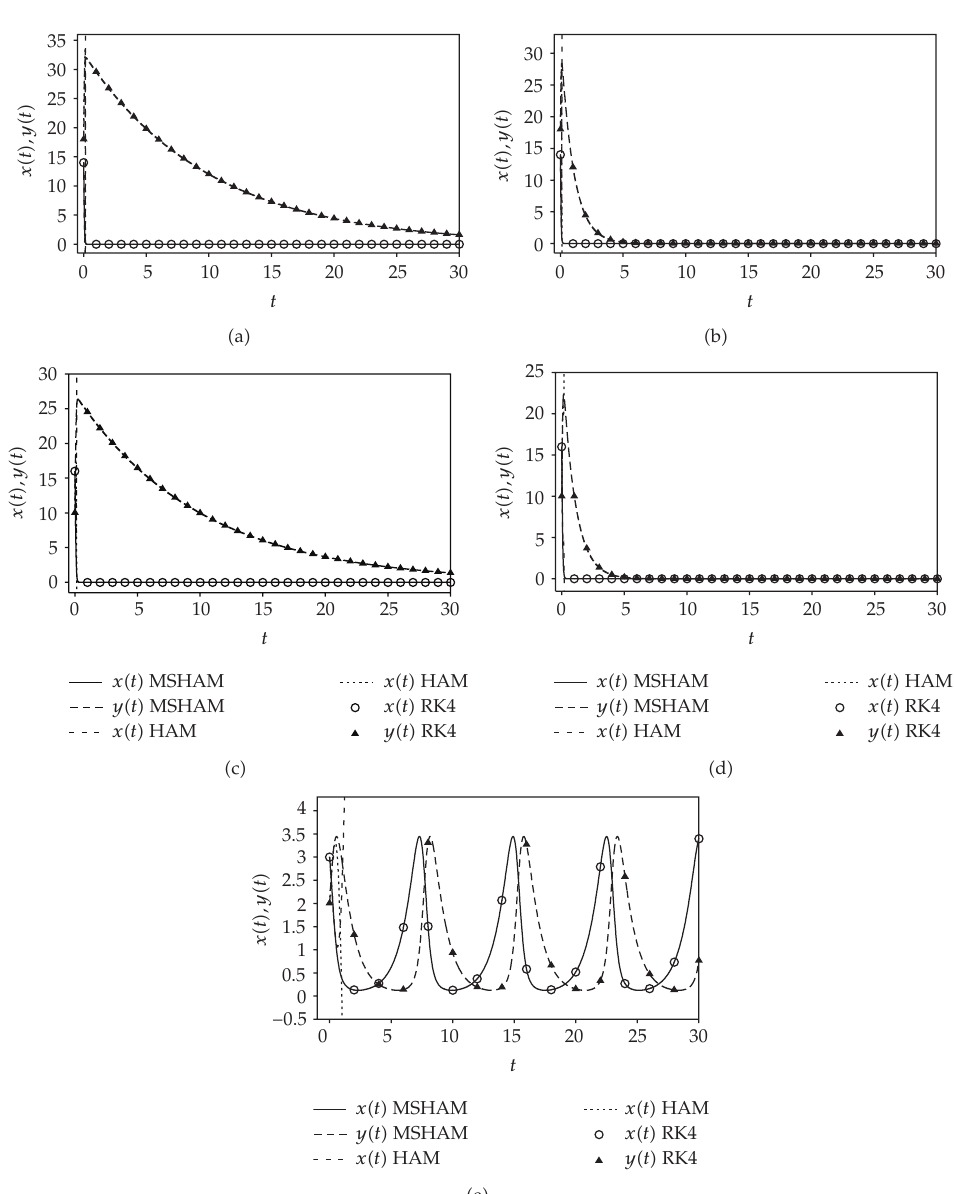
Figure 2: Comparisons between the populations of rabbits x and foxes y at time t for (cid:3) a (cid:4) Case 1, (cid:3) b (cid:4) Case 2, (cid:3) c (cid:4) Case 3, (cid:3) d (cid:4) Case 4, and (cid:3) e (cid:4) Case 5, using the 4th-term classical HAM, 4th-term MSHAM (cid:3)Δ t (cid:5) 0 . 01 (cid:4) , and RK4 (cid:3)Δ t (cid:5) 0 . 001 (cid:4)